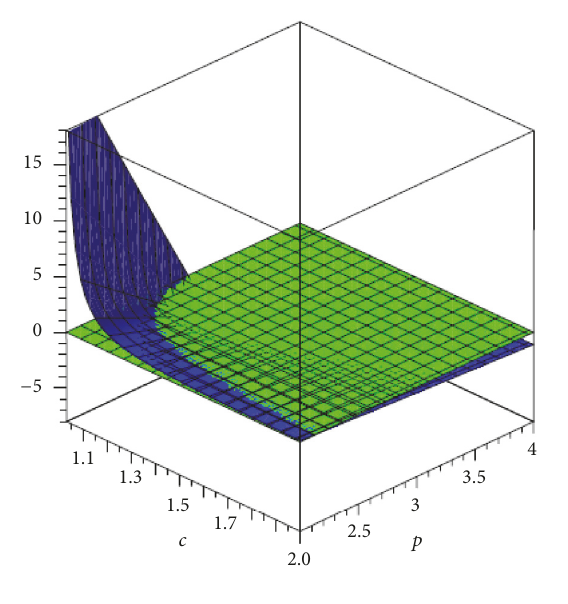
Figure1:The3Dimageof 𝑑 󸀠󸀠 (𝑐) when 𝛼 = 1 , 𝛽 = 1 , 𝛾 = 3 , 2 < 𝑝 < 4 .